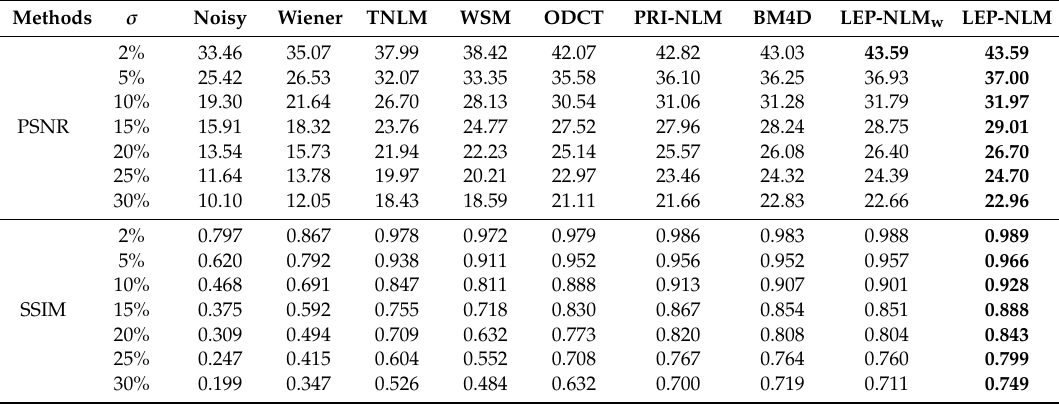
Table 3. PSNR / dB and SSIM comparison on the simulated T2-weighted images at di ff erent noise levels for the Wiener, TNLM, WSM, ODCT, PRI-NLM, BM4D, LEP-NLM, and LEP-NLM w methods.